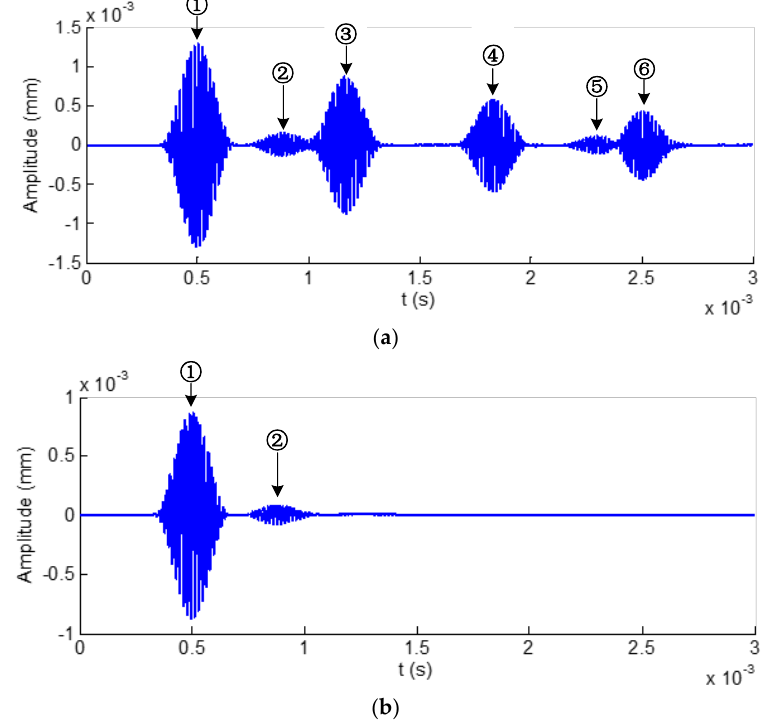
Figure 12. Time domain waveforms received from a hexagonal drill pipe: ( a ) Without and ( b ) with applying ALID regions.